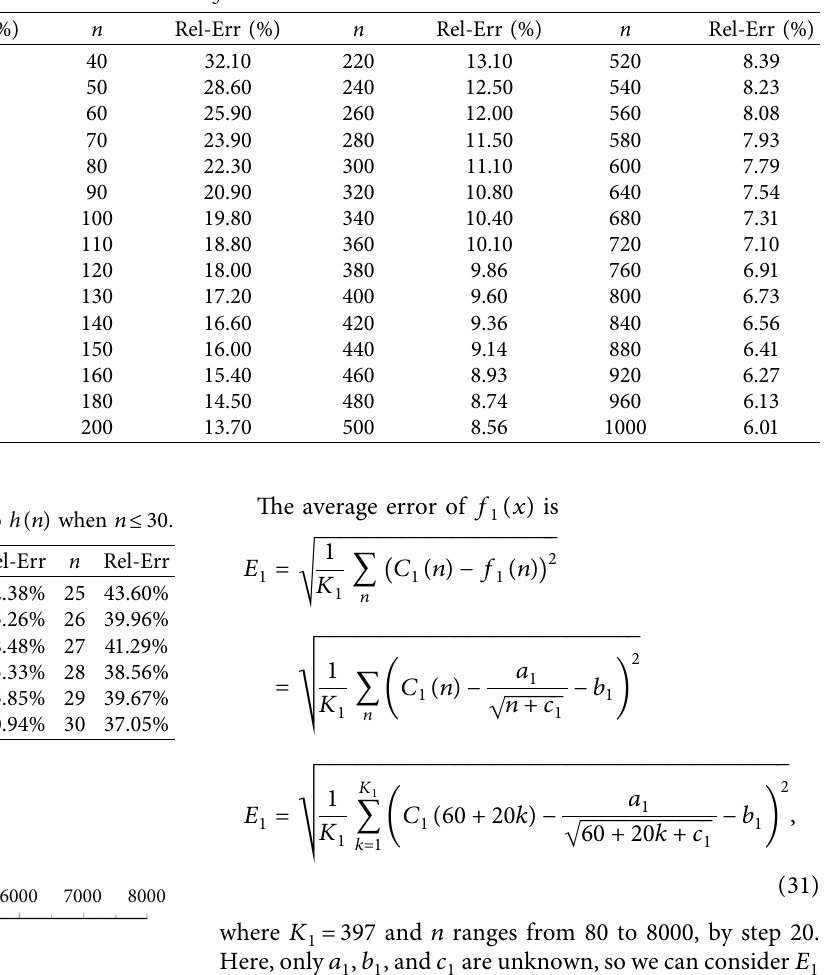
Table 4: The relative error of I